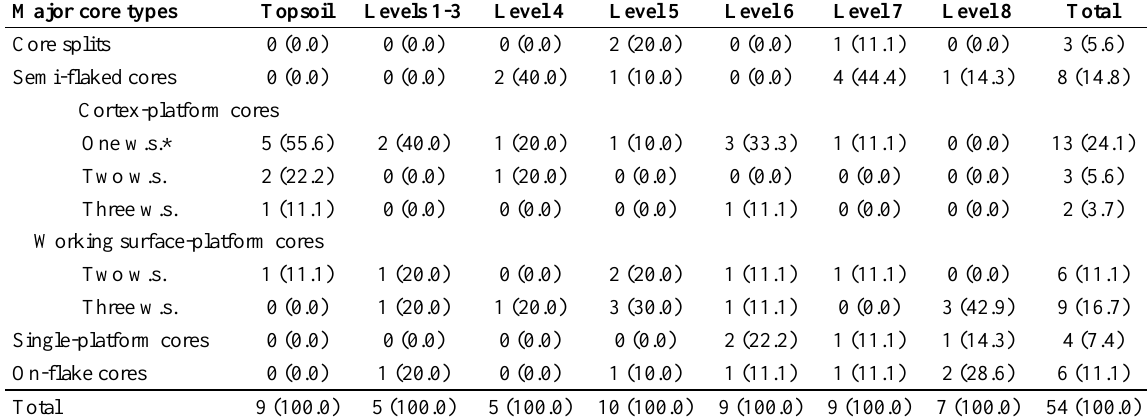
Table 2. Technological types for cores from Square 2 of Tell Ghanem al-Ali. Abbreviations: w.s.: working